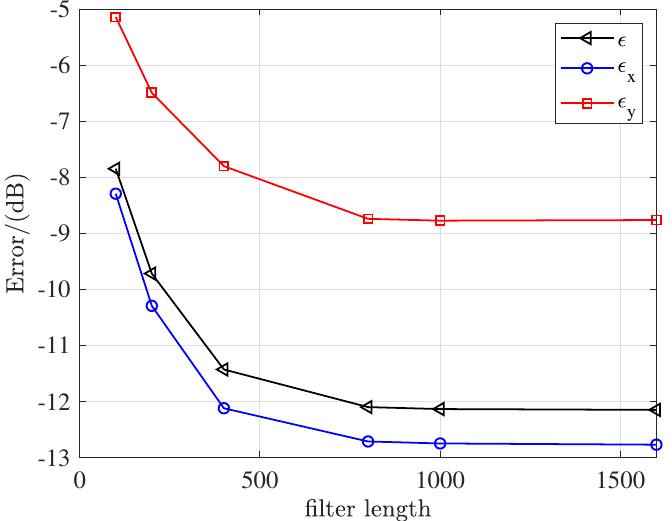
Figure 4. The NMSE of the reproduced intensity at controlled points with varying filter length. The tuning parameter τ = 0.5 and reverberation time RT 60 = 200